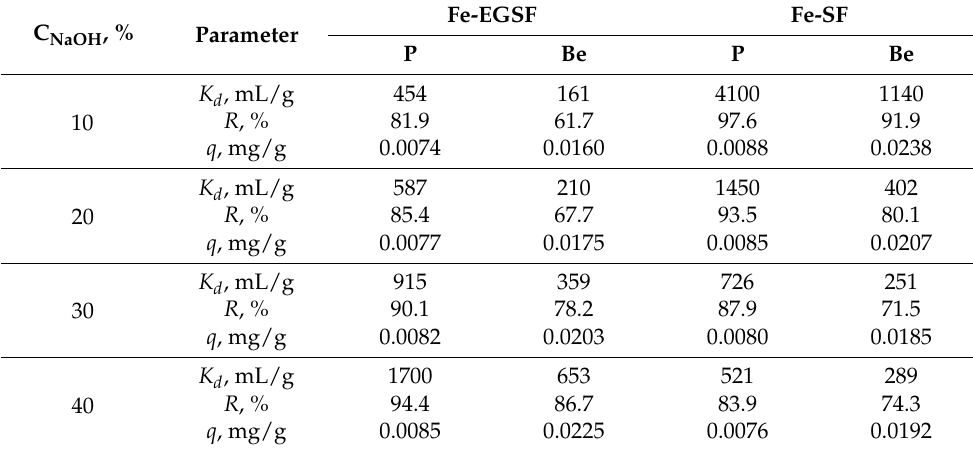
Table 1. Influence of the initial concentration of NaOH in the initial impregnation solution in the preparation of Fe-EGSF and Fe-SF on the sorption parameters of phosphorus and beryllium. Fe-EGSF C NaOH , % Parameter